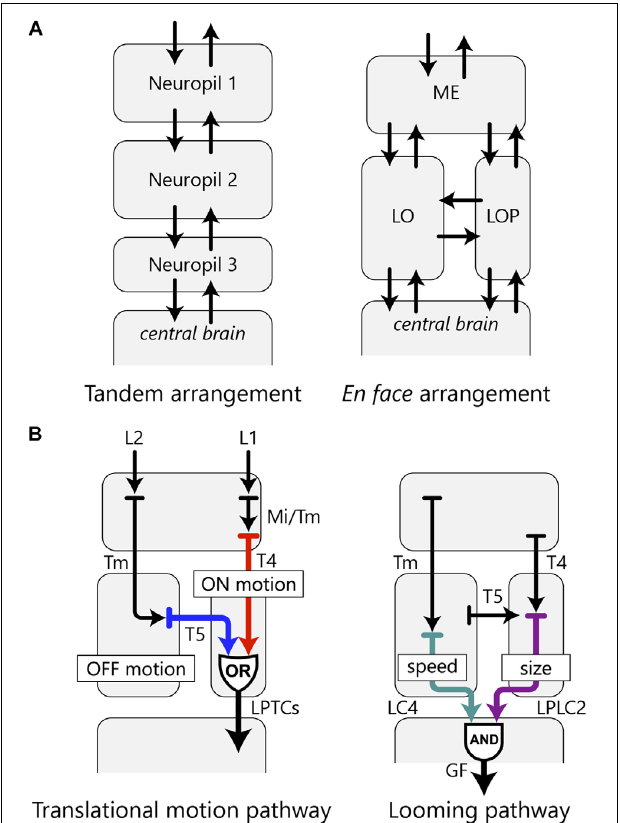
FIGURE 6 | OCH2 and the arrangement of the optic lobe neuropils. (A) A hypothetical tandem arrangement (left) compared with the actual en face arrangement (right) of the optic lobe neuropils. The en face arrangement has more possible pathways between the neuropils as well as between the optic lobe and the central brain. (B) Two examples of information integration in the fly’s visual system accomplished by parallel information processing in multiple neuropils. The translational motion-processing pathway implements an OR operation, whereas the looming pathway implements an AND operation with the optic lobe